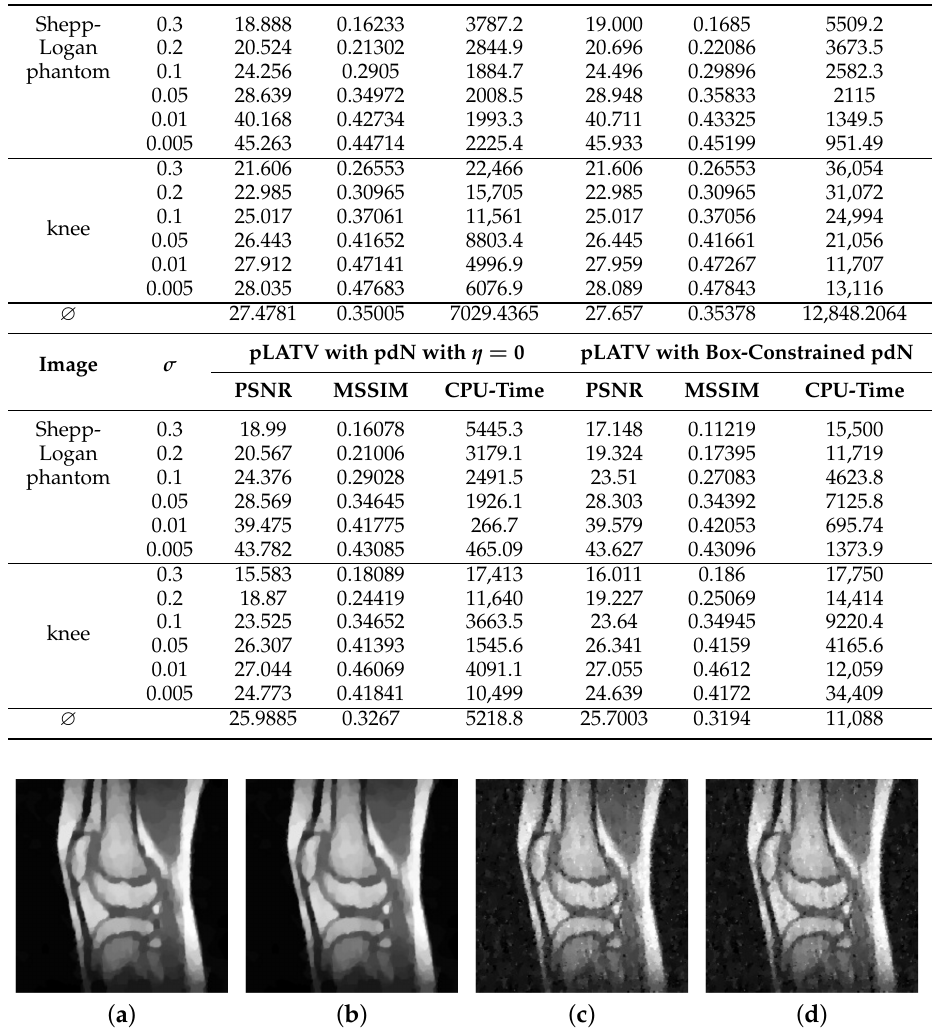
Table 13. PSNR- and MSSIM-values of the reconstruction of sampled Fourier data corrupted by Gaussian white noise via the pAPS- and pLATV-algorithm using the primal-dual Newton method. pAPS with pdN with η = 0 Image σ